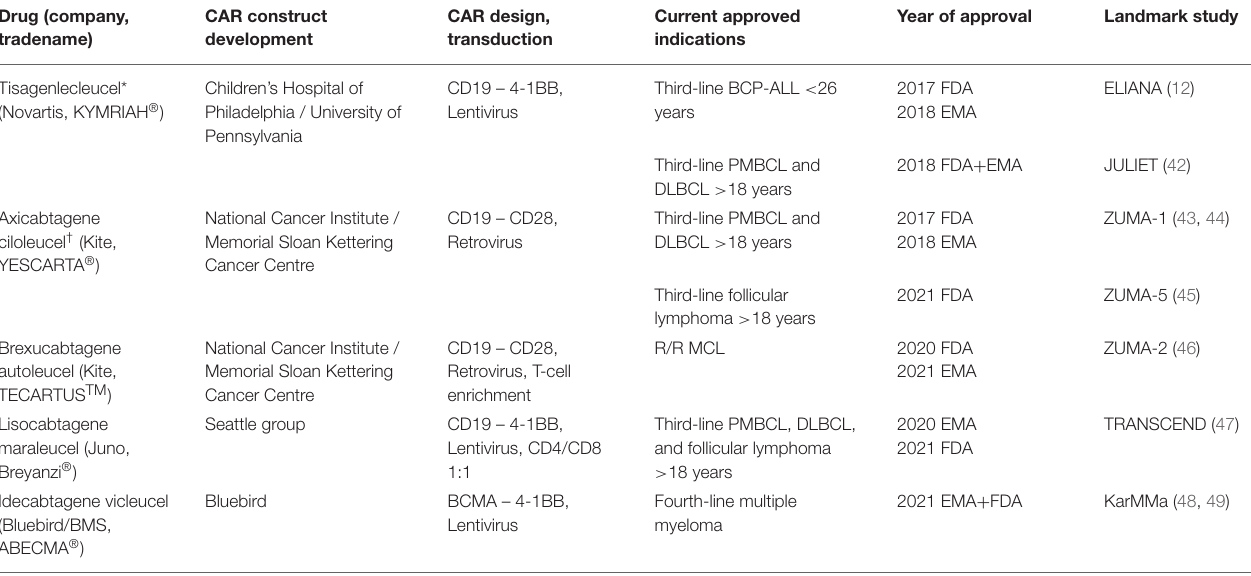
TABLE 2 | CAR-T products with approved market authorisation (by July